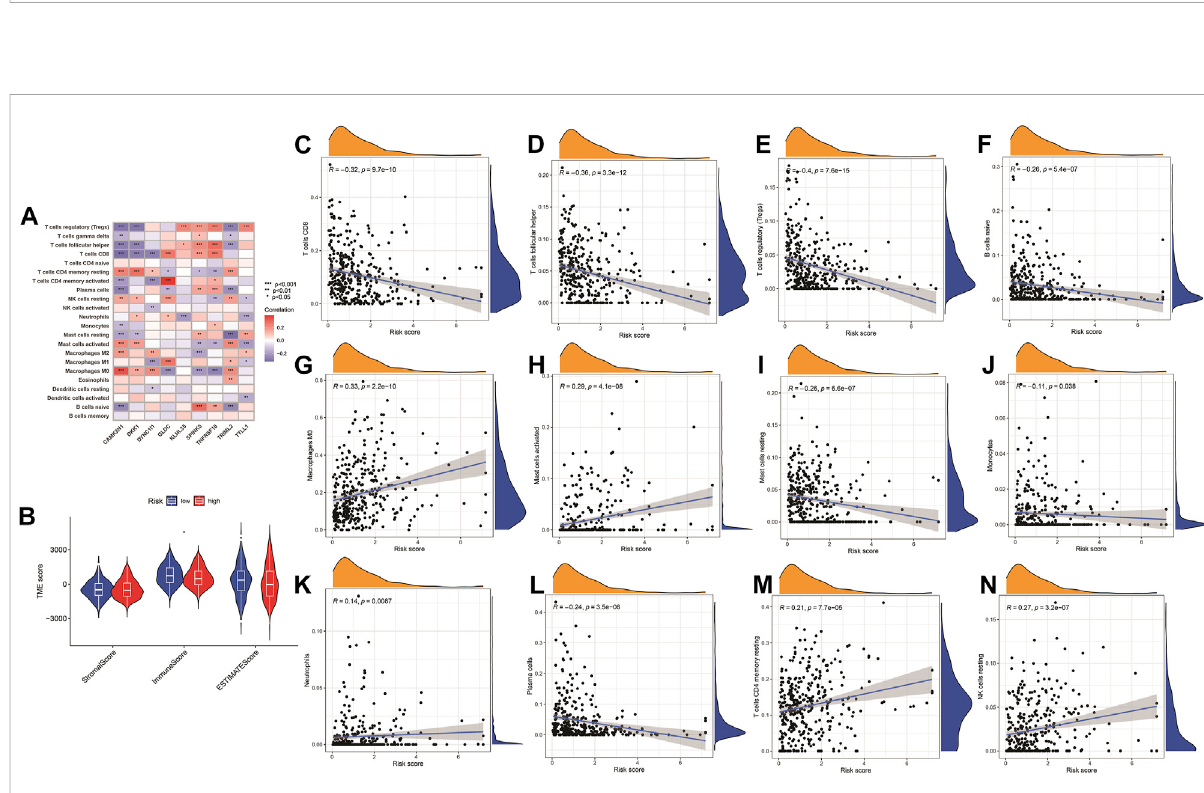
FIGURE 12 Immune checkpoint analysis. (A) The expression of PRGs and immune cells between low- and high-risk groups. * p < 0.05, ** p < 0.01; *** p < 0.001. (B) Violin plot for a stromal score, immune score, ESTIMATE score, and tumor purity score between high- and low-risk groups. (C – N) Correlation analysis of the risk model and immune cells in fi